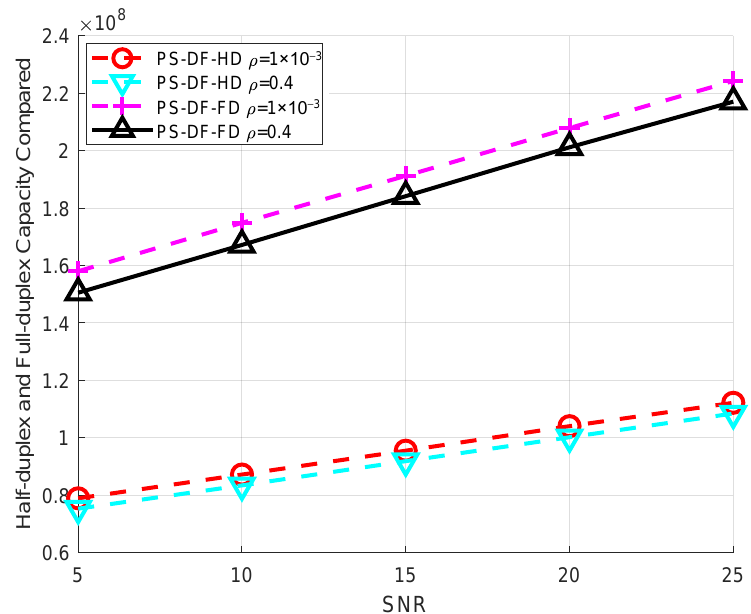
Figure 12. Half-duplex and full-duplex capacity